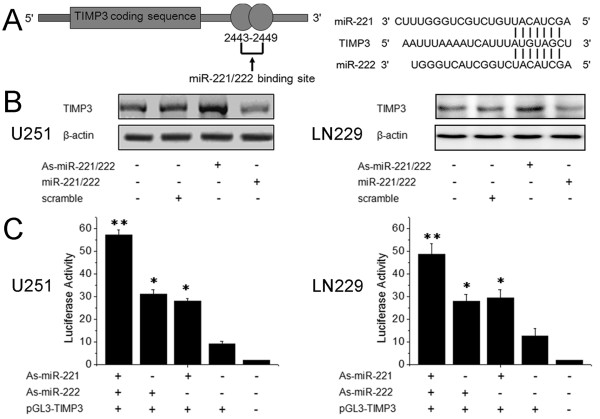
TIMP3 is a target for miR-221 and miR-222. (A) Schematic representation of the putative binding sites in the TIMP3 mRNA 3' UTR for miR-221 and miR-222 (the seed sequence (AGCUACAU) was identical, as shown). (B) Cells were transfected with As-miR-221/222 or miR-221/222 and TIMP3 protein levels were detected by western blot assays. β-actin protein was assayed as a control. (C) pGL3-TIMP3-3'UTR luciferase constructs were transfected into cells that were then treated with As-miR-221 and/or As-miR-222. Luciferase activity was determined 48 h after transfection. The ratio of normalized sensor to control luciferase activity is shown. Error bars represent standard deviation and were obtained from three independent experiments. * P <0.05 compared with control group, ** P <0.01 compared with control group.